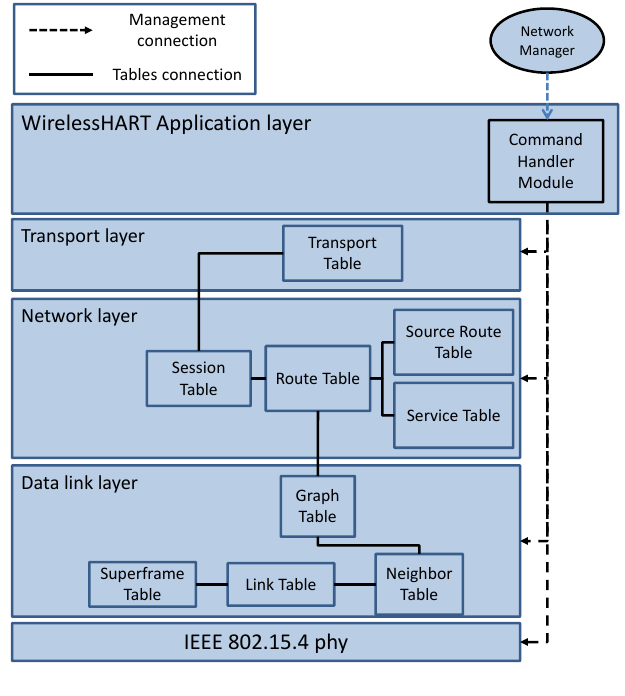
Figure 5. WirelessHART protocol